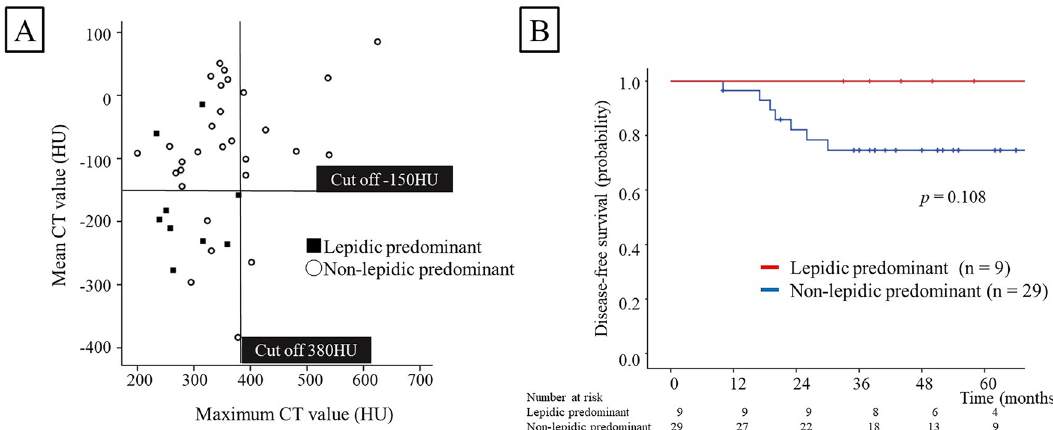
Figure 3. ( A ) Relationship between the mean and maximum CT values. The lines indicate the optimal cutoff value for the mean CT value (− 150 HU) and the maximum CT value (380 HU). The sensitivity and specificity for lepidic predominant lesions were 77.8% and 86.2%, respectively. ( B ) Kaplan–Meier survival curves for disease-free survival (DFS). Patients with lepidic predominant lesions experienced no recurrences.